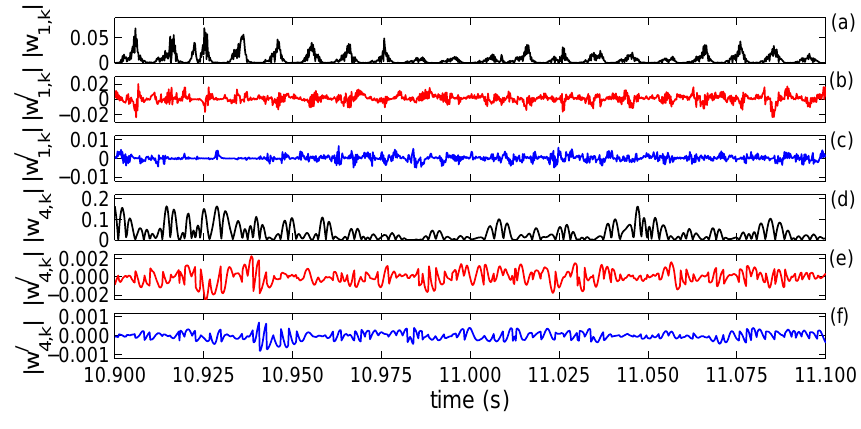
Fig. 12. Modulus maxima of wavelet coefficients for the time series for u 1 are shown in (a) and (d) at j = 1 and j = 4, respectively. The data in (b) and (c) , as well as (e) and (f) show the difference (indicated by a prime) between | w j,k | and the values from a wavelet decomposition of a surrogate data series (for ρ = 0 . 99 in (b) and (e), and shown in red; for ρ = 0 . 999 in (c) and (f), and shown in blue).